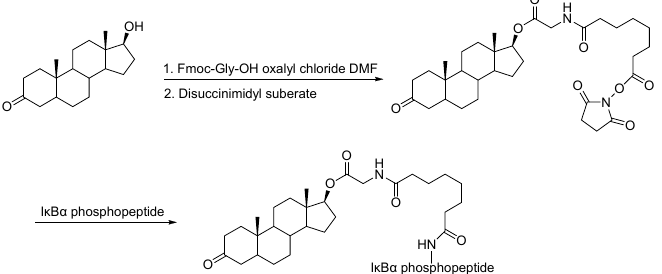
Table 1. Natural products 1–2.